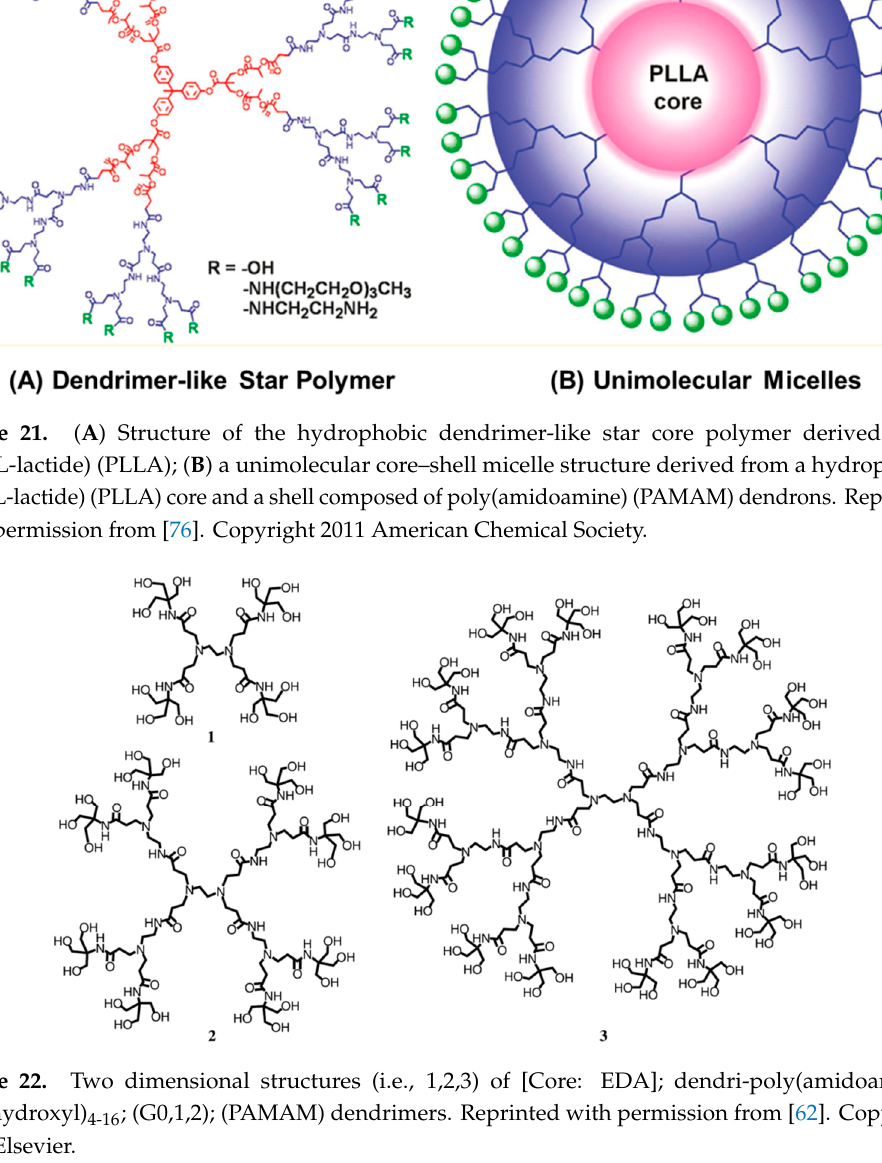
Figure 23. Comparison of drug-loading ability of G3, poly(amidoamine) (PAMAM) and G3, poly(propyleneimine) (PPI) dendrimers using a gradient feed method. Reprinted with permission [81]. Copyright 2011 Dove Medical Press. Note: The authors used old nomenclature and mislabeled